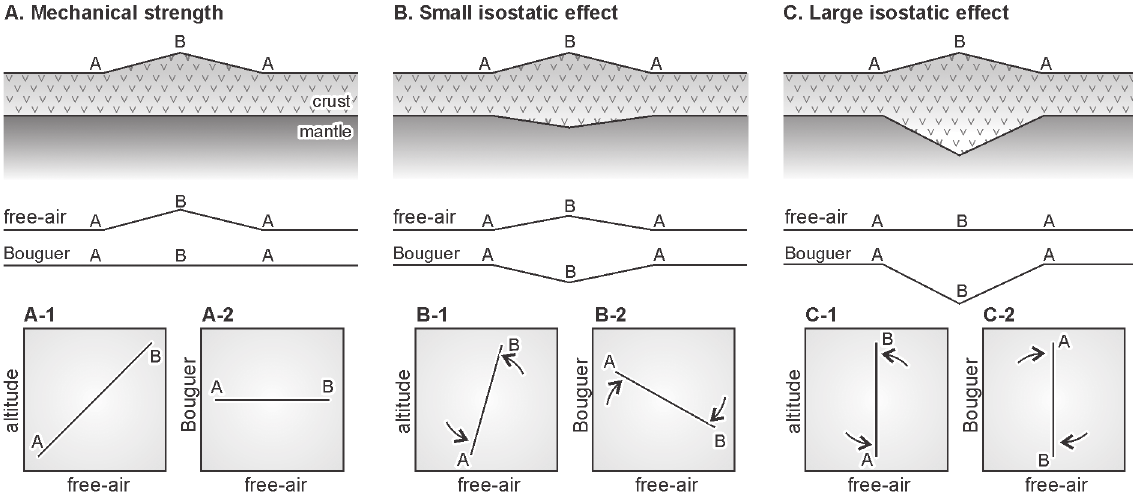
Figure 10 - Geologic structure models suggested by topographic and gravimetric data, modified from Motoki (2013): A) Hill sustained entirely by mechanical strength of the basement or active tectonic uplift; B) Hill sustained also by small effect of isostatic compensation; C) Hill with large effect of isostatic